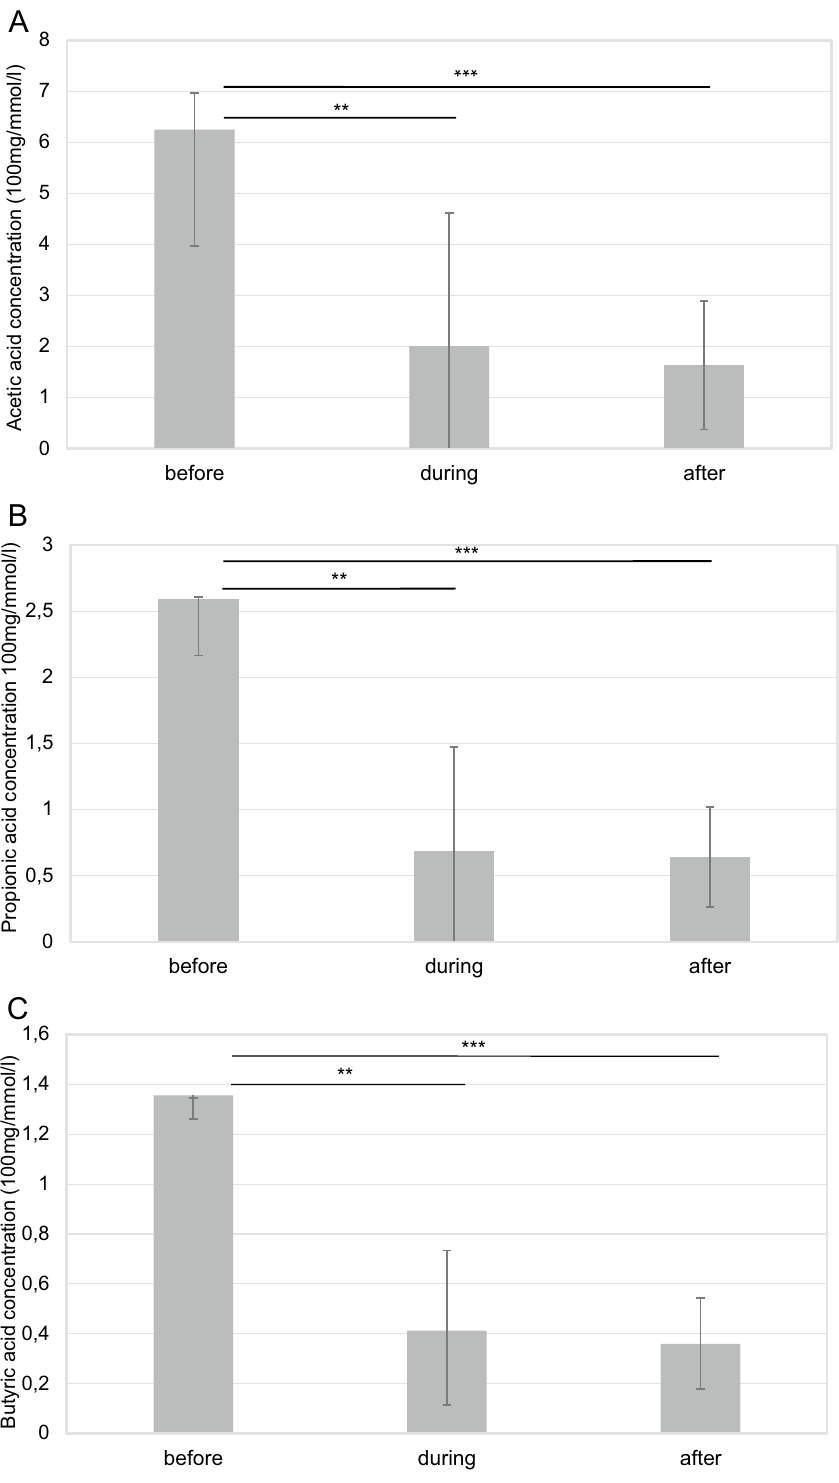
Figure 4. The effect of antibiotics treatments on the acetic acid ( A ), propionic acid ( B ) and butyric acid ( C ) concentrations (100 mg/mmol/l) in the faecal samples before-, during- and after the antibiotics treatment. Abx: broad-spectrum antibiotics treated group; Friedman test (** p < 0.01; *** p < 0.001). Data graphed as median ±